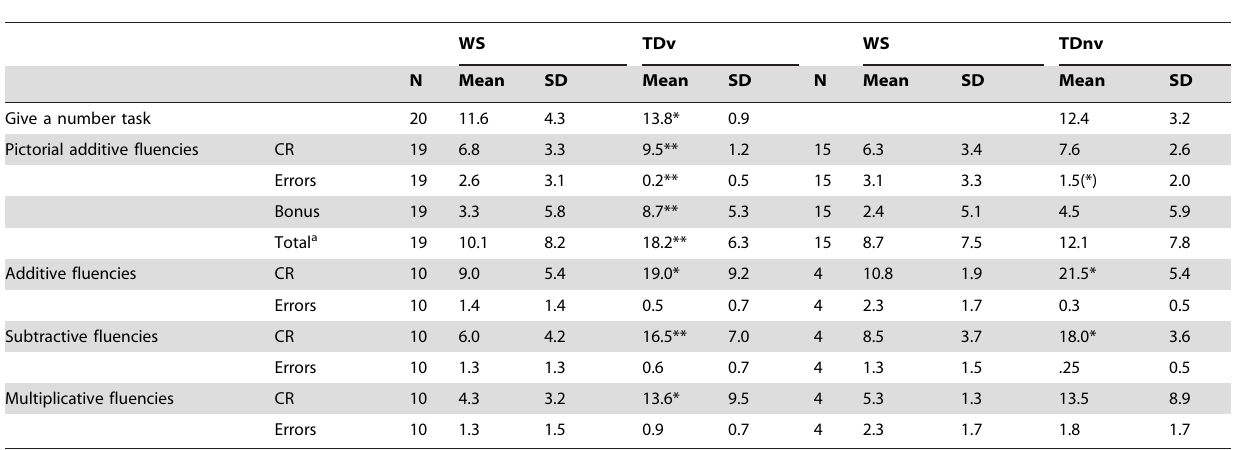
Table 3. Mean Performance in the Mathematical Tasks by